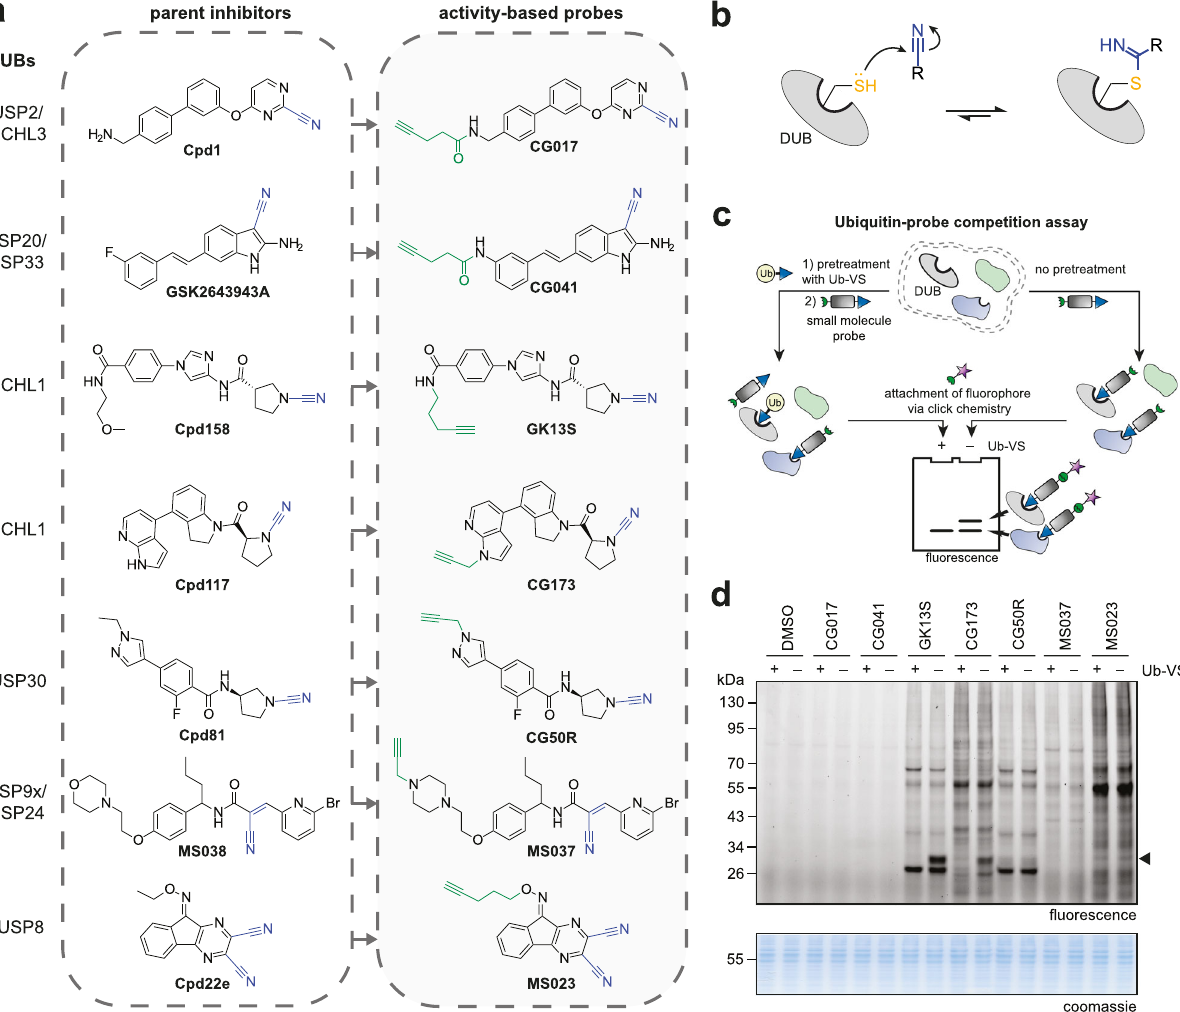
Fig. 1 | Design and evaluation of an activity-based probe library derived from nitrile-based DUB inhibitors. a Synthesized activity-based probes (right panel) derived from known inhibitors (left panel), containing a potential nitrile-based warhead (blue) for covalent protein modi fi cation and an alkyne handle (green) for bioorthogonal functionalization. See the supporting information for chemical synthesis routes. b Mechanism of thioimidate formation between DUB active site cysteine and small molecule nitrile. c Ubiquitin vinyl sulfone (Ub-VS) competition work fl ow. Cell lysates were either incubated with a Ub-VS probe followed by small